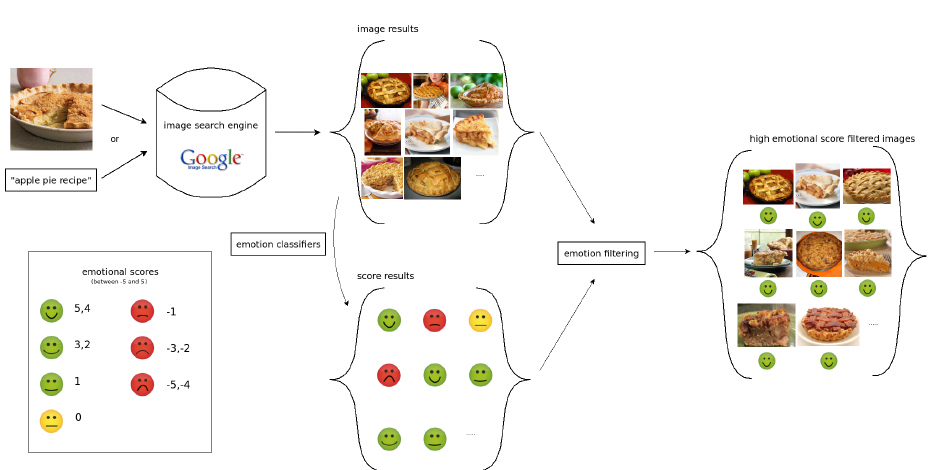
Figure 8. Emotional filtering model. In this example, only high emotional score images are displayed as a result of the filter